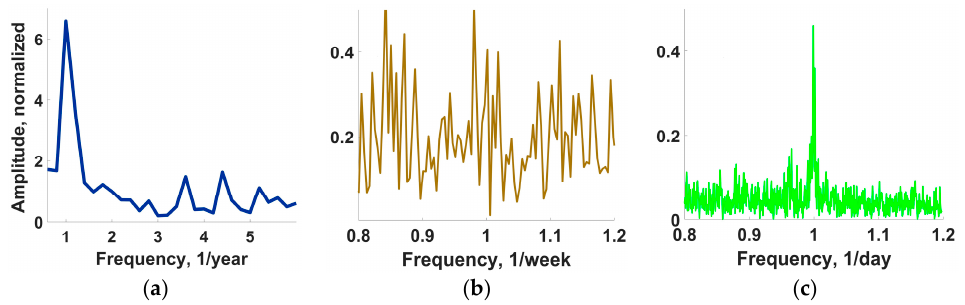
Figure 12. The Fourier spectrum of the median resistance value of the multisensor array in the e-nose measured in the years 2009–2017. The spectrum sections are given near the ( a ) annual peak; ( b ) weekly peak; and ( c ) daily peak. Yearly and daily peaks exceed essentially the local mean-spectrum level; the weekly peak does not.